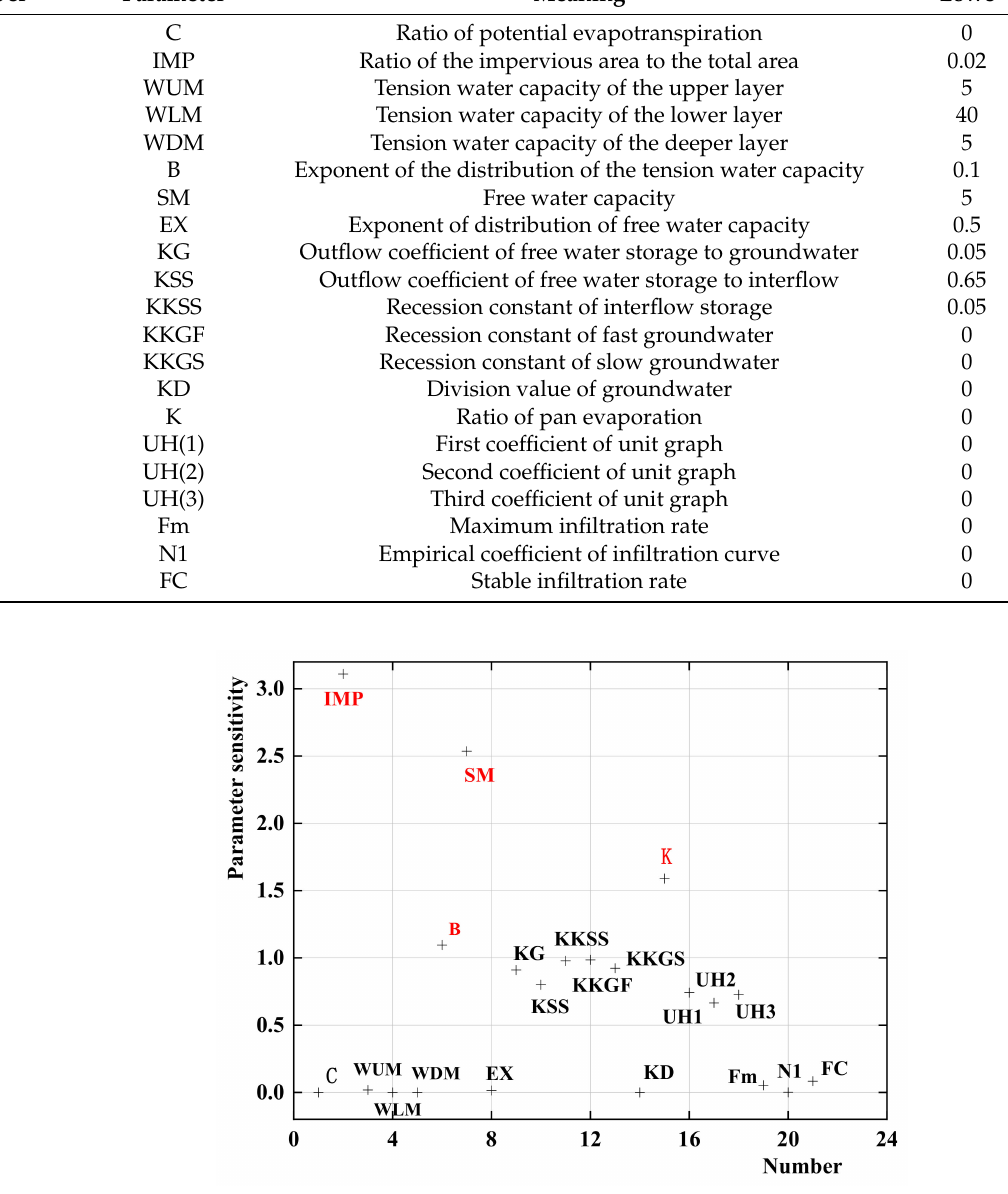
Figure 2. Scatter plot obtained from the sensitivity